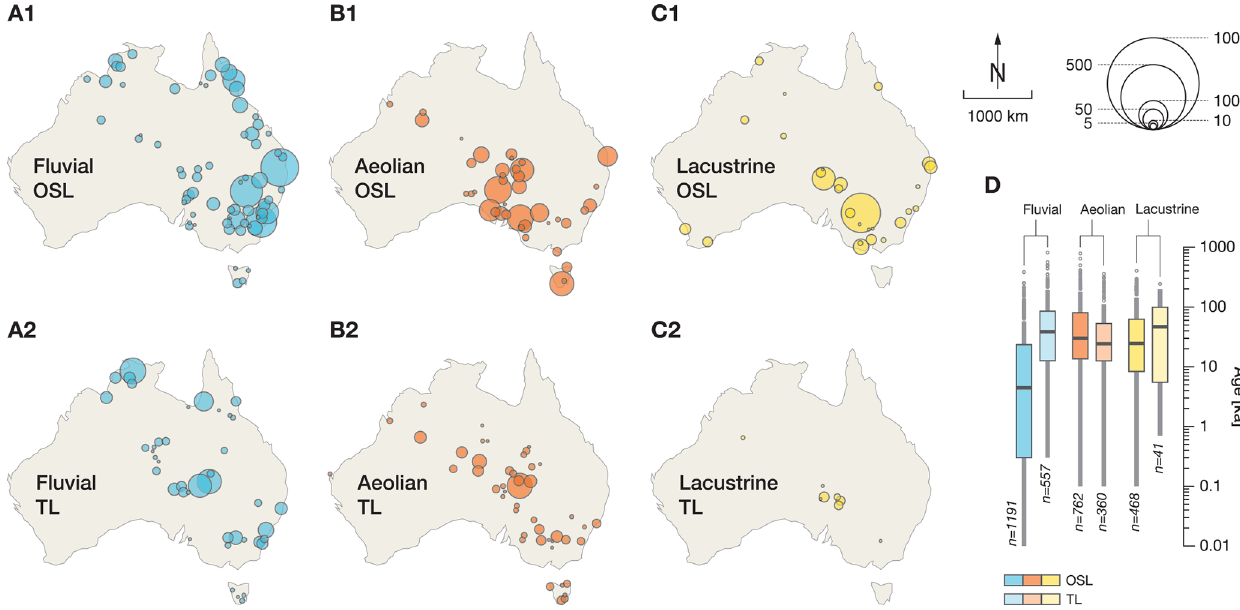
Figure 5. The SahulSed data collection, showing the distribution of sample sites and ages. The size of circles corresponds to the number of observations in each 50km radius cluster. Box plots are standard interquartile range (IQR) plots with outliers defined as data points > 1 . 5 × IQR. Box plots only include observations with non-zero ages. Box plot colours are as follows: blue – fluvial, red – aeolian, and yellow –